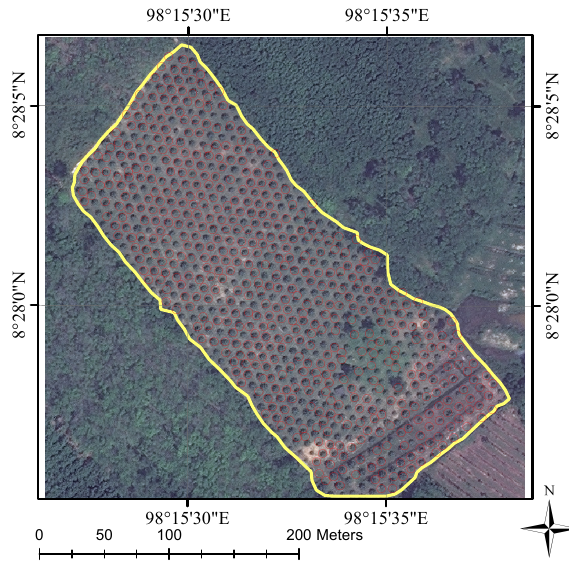
Figure 10. The oil palm detection result on the test area shown in Figure 4a using excess green index which gave the lowest metric between the histogram of oil palm tree and that of background. The detected of palm trees are marked with red circles. Note that the diameter of red circles has no relationship with the diameter of tree